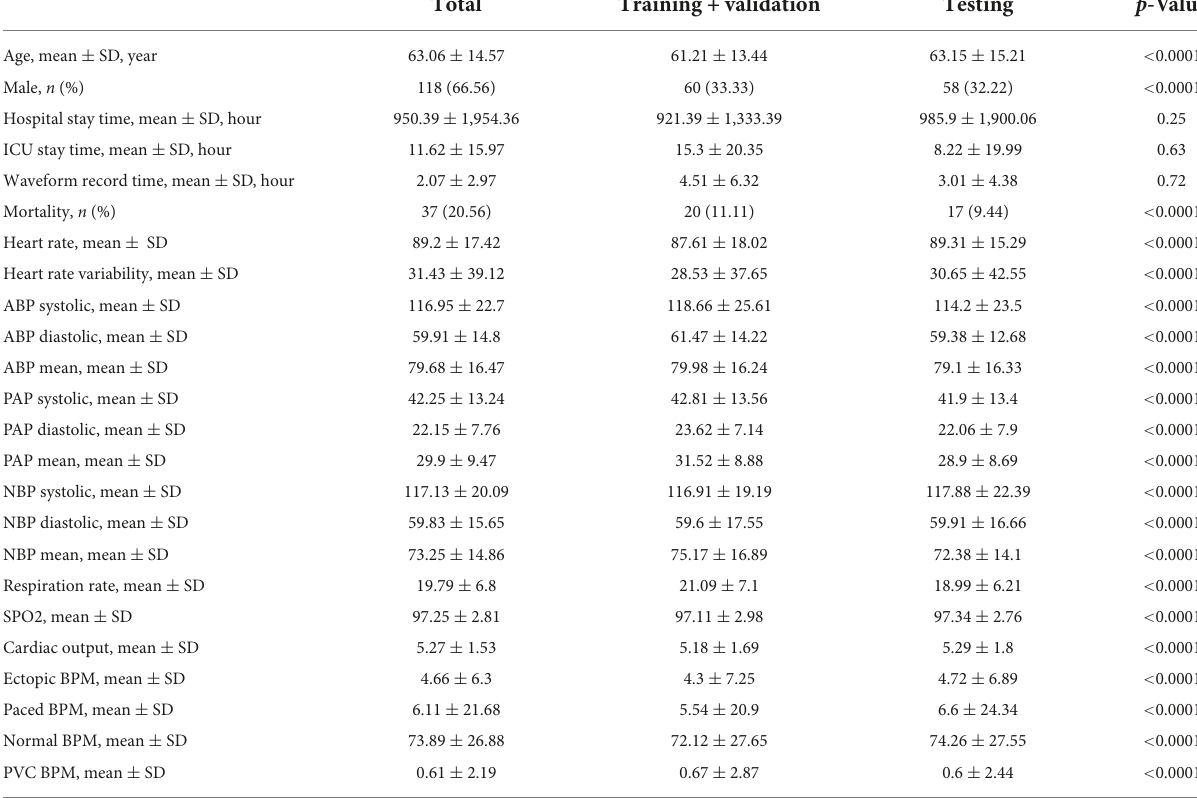
TABLE 1 Summary statistics of demographic data and clinical characteristics of all patients. Total Training + validation